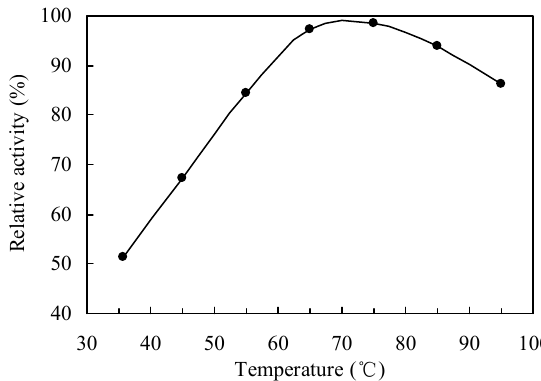
Figure 1. The relative activity of immobilized lipase as a function of temperature.